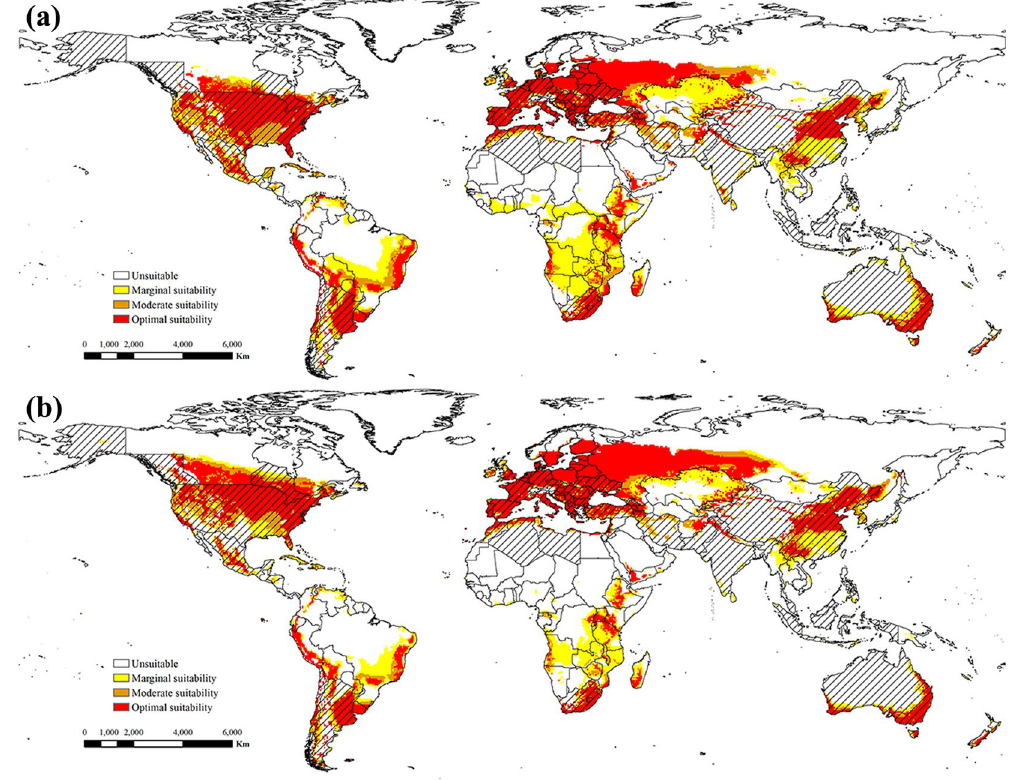
Figure 4. The projected global climate suitability for EBR under climate change scenario RCP 8.5, ( a ) the middle of 21st century (2046–2065), ( b ) the end of 21st century (2081–2100). Slash indicate the distribution countries of tree-of-heaven. Yellow indicates areas of marginal suitability (0 < EI ≤ 10); Orange indicates areas of moderate suitability (10 < EI ≤ 20); Red indicates areas of optimal suitability (EI ≥ 20). The map in this figure was generated by ArcGIS 10.1 (ESRI, Redlands, CA, USA,